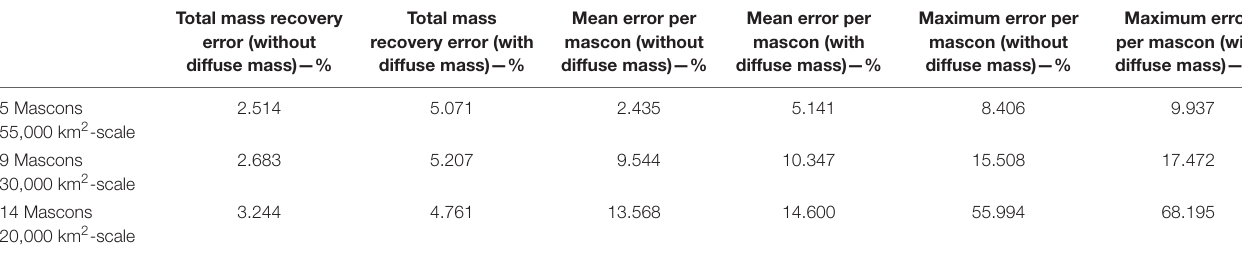
Frontiers in Earth Science |